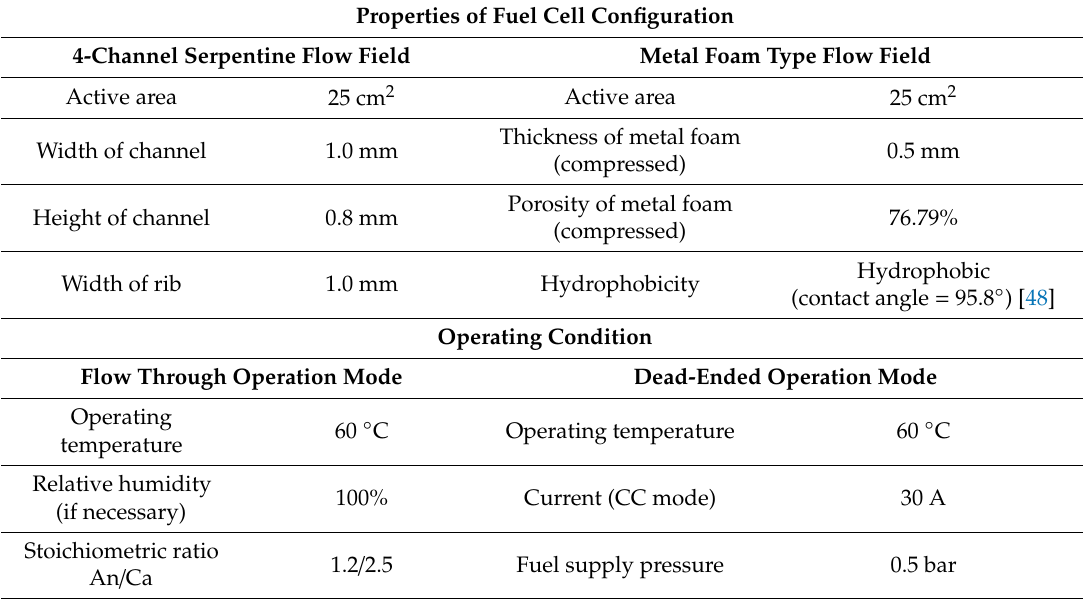
Table 1. Properties of fuel cell configuration and operating conditions.